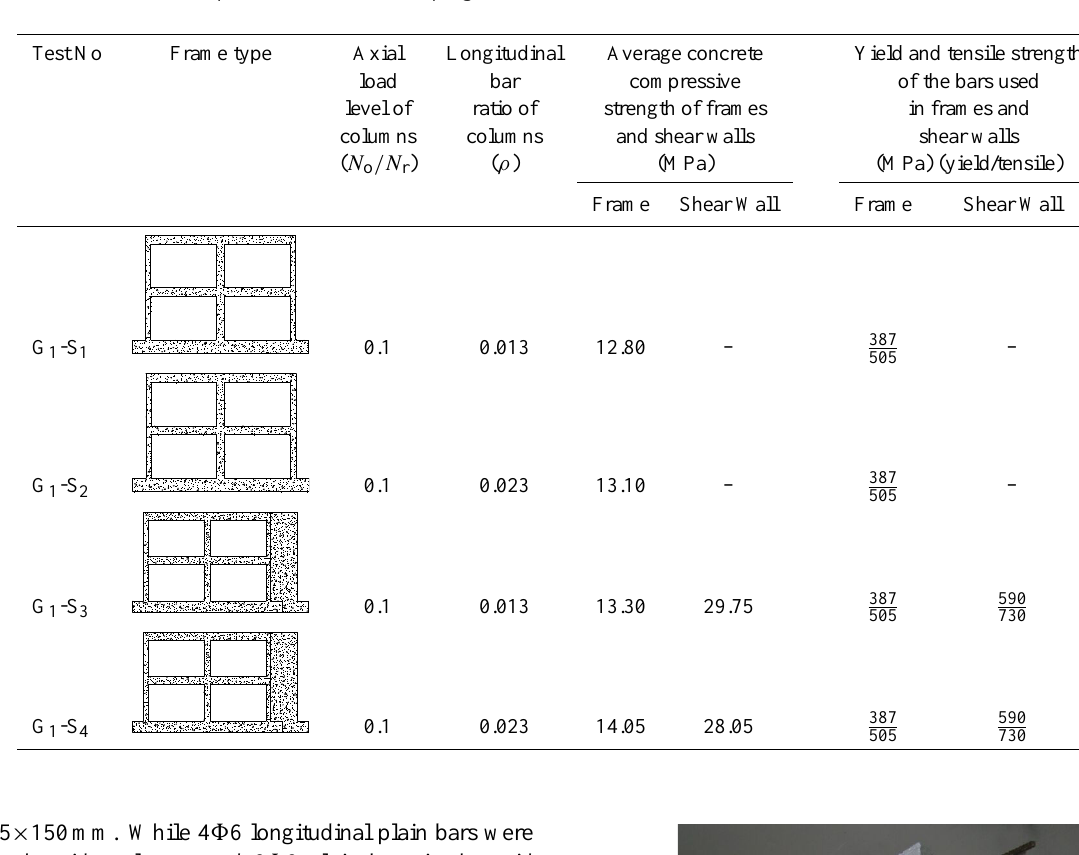
Table 1. Characteristics of the specimens in the 1 st test program Average concrete compressive strength of frames